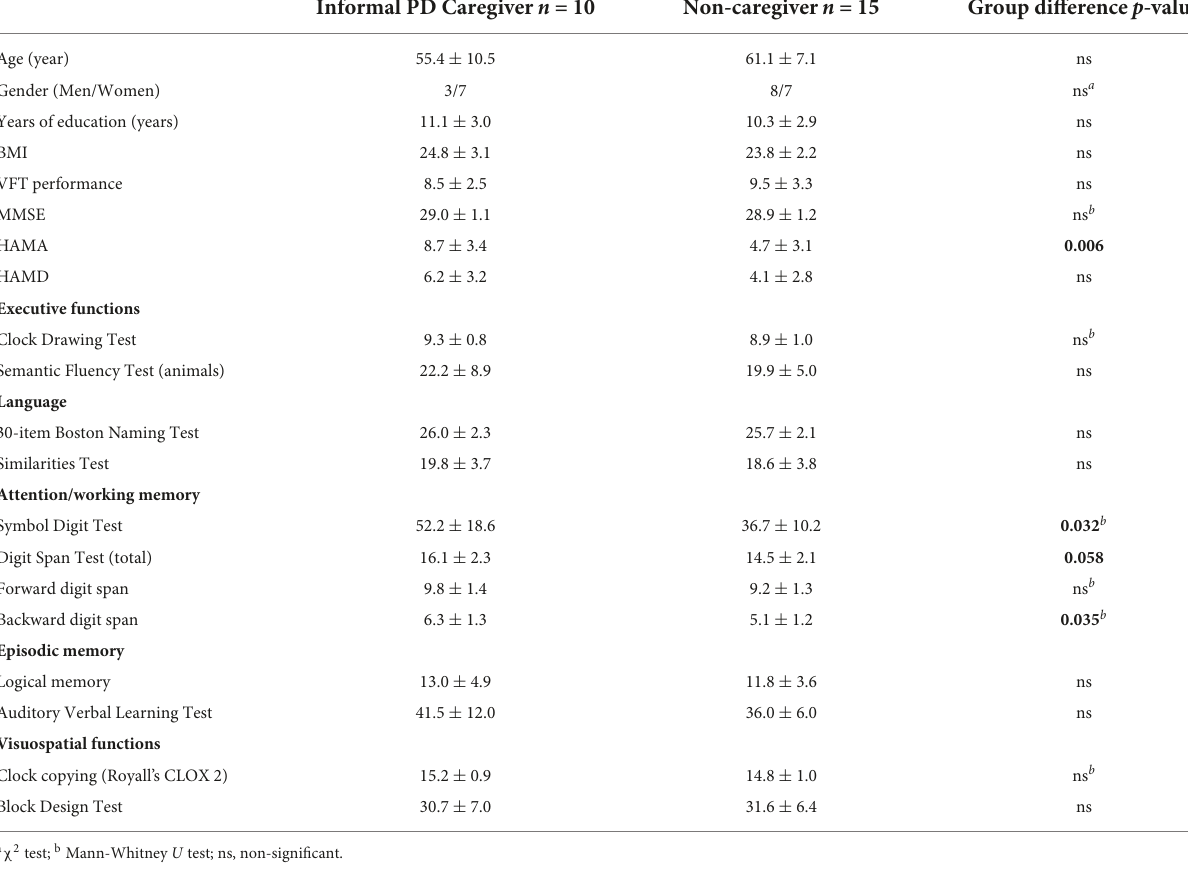
TABLE 1 Demographic characteristics of informal PD caregiver and non-caregiver.